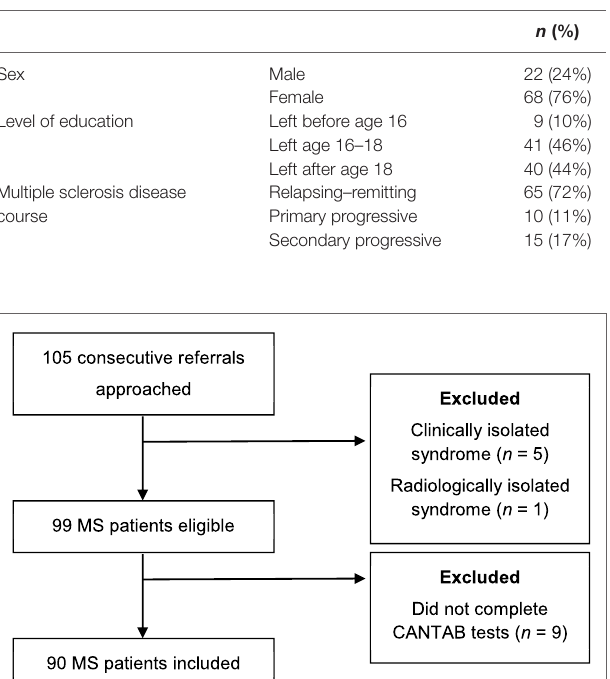
TaBle 1 | Patient clinical and demographic